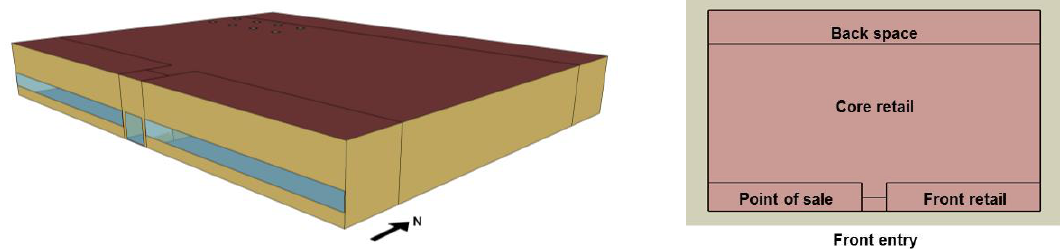
Figure 1. Standalone retail building prototype. Left : Building shape and orientation. Right : Layout of five thermal zones [18].